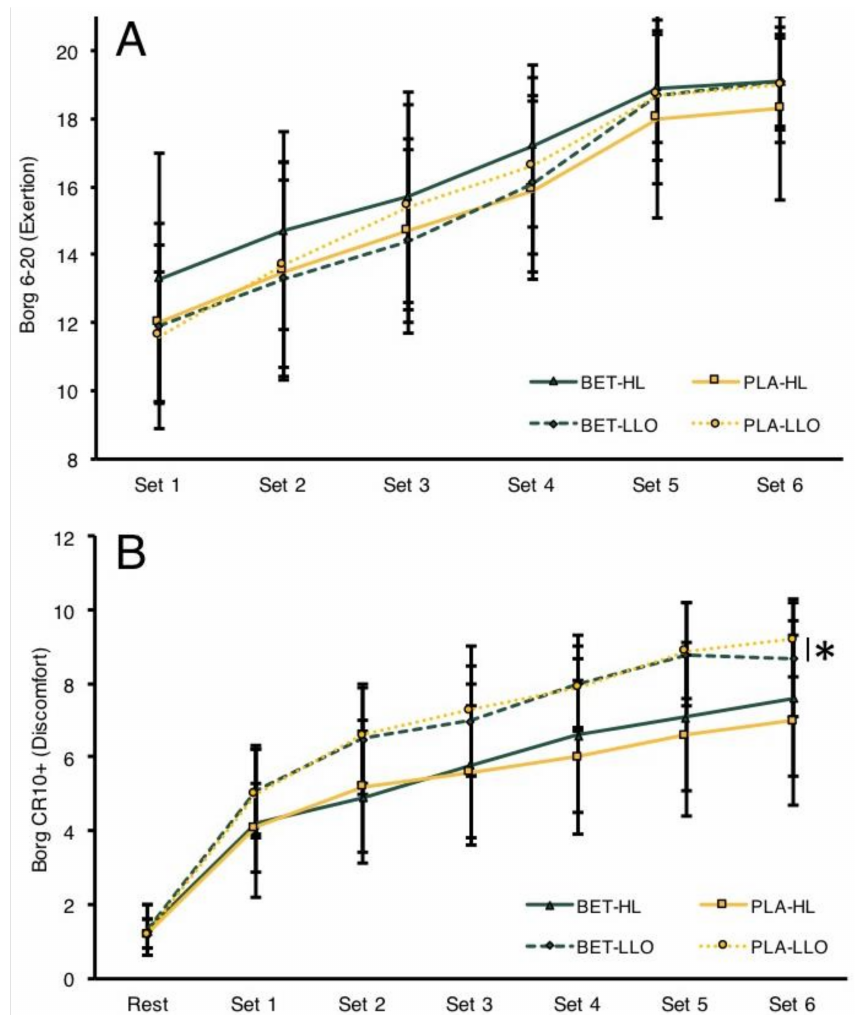
Figure 2. Rated perceived exertion (RPE; ( A ) changes from sets 1 through 6 and subjective discomfort (CR10+; ( B ) changes from resting through set 6. All data are displayed as means ± SD. * Indicates significant supplement-collapsed exercise condition effect ( p < 0.001), whereby LL-BFR displayed greater subjective discomfort versus